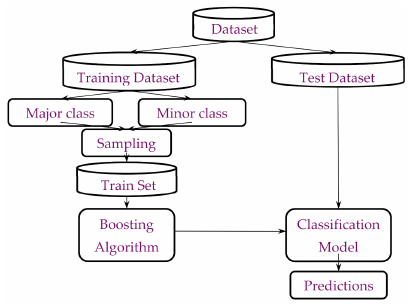
Figure 2. Scheme specific flow